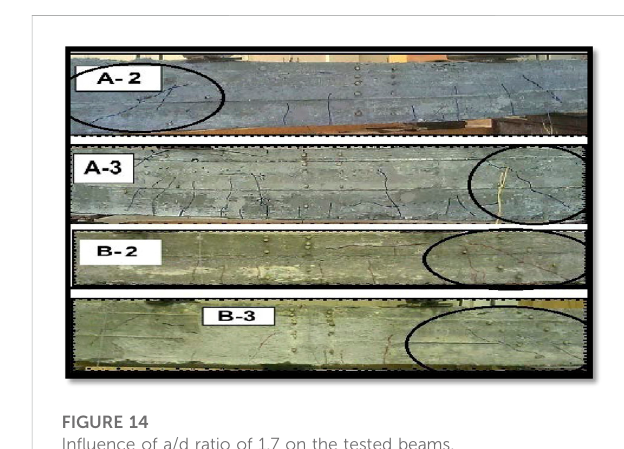
FIGURE 14 In fl uence of a/d ratio of 1.7 on the tested beams.